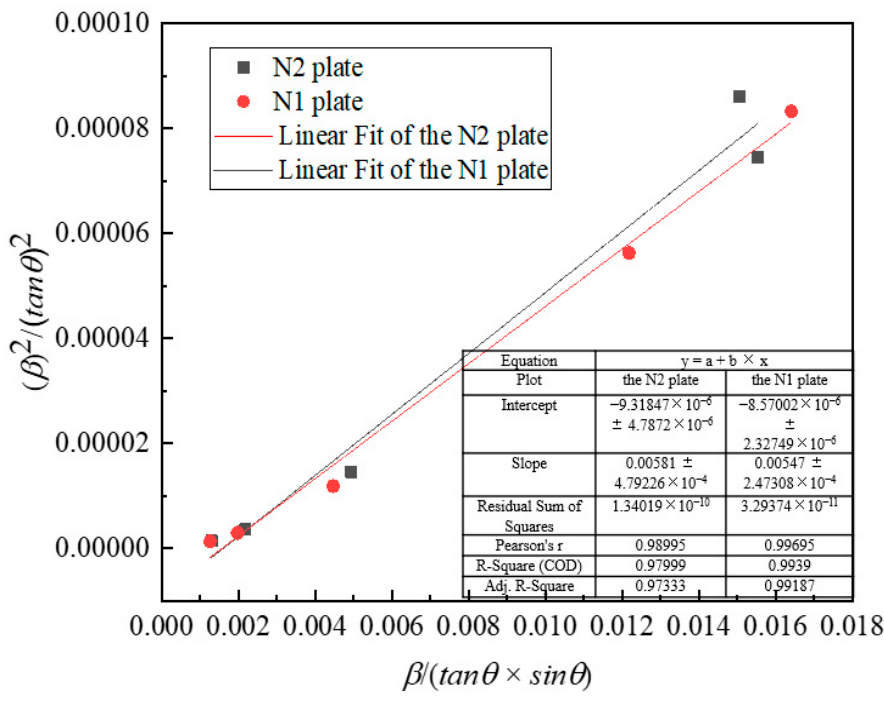
Figure 13. Linear fitting of Equation (2) of hot rolled 1561 aluminum alloy.